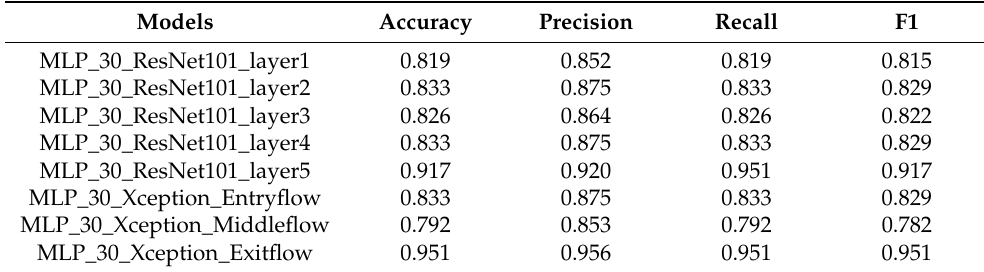
Table 6. The validation set results for modeling the fusion of different layers of convolutional networks with spectral